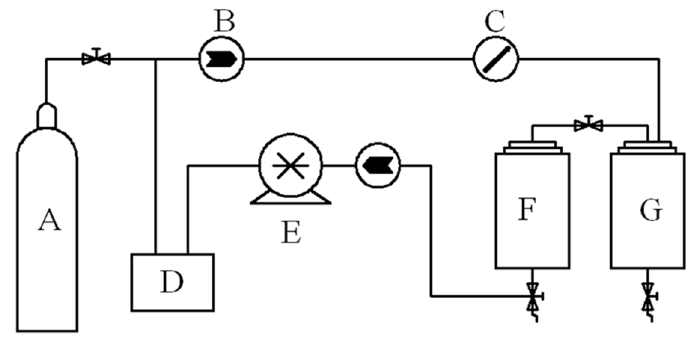
Figure 4. Schematic diagram of experimental apparatus. A: CO 2 cylinder; B: check valve; C: flow meter; D: cold liquid circulator; E: piston pump; F: extraction vessel (1 L and 0.55 m height); G: separation vessel (0.6 L).